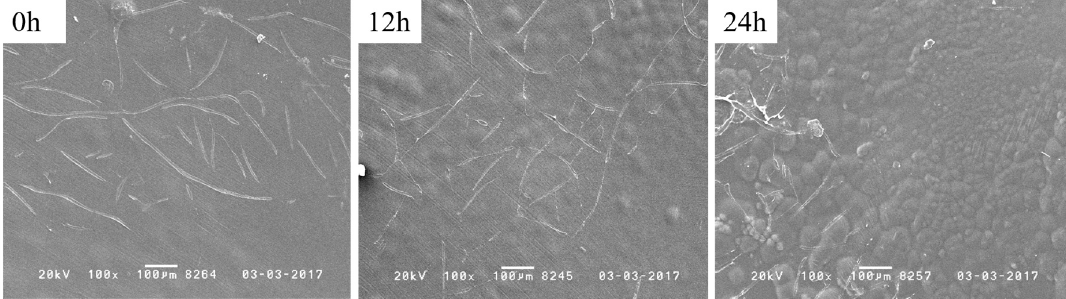
Figure 8. Scanning electron micrograph (SEM) of the internal (collagen) layer of scales at different storage times.